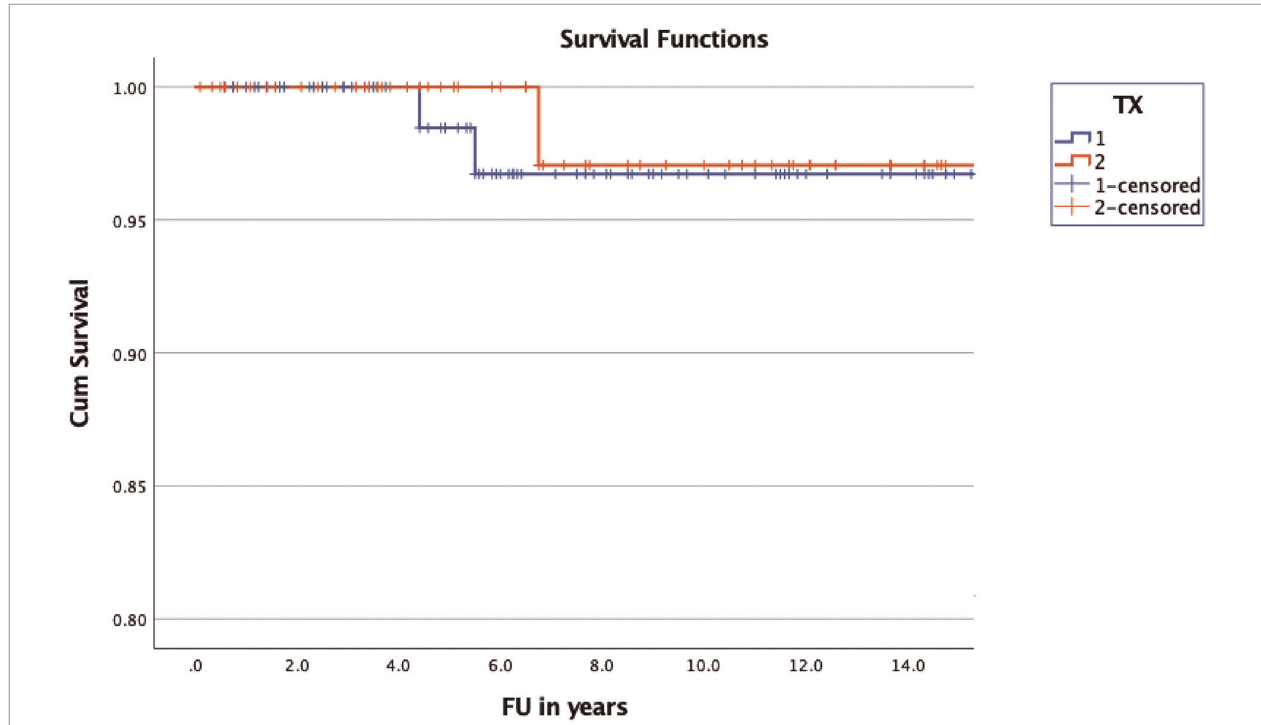
FIGURE 3 | Kaplan-Meier curve illustrating the OS of children with NF1 and OPG. The difference of OS between treated (blue) and non-treated (red) children was statistically not signi fi cant ( p